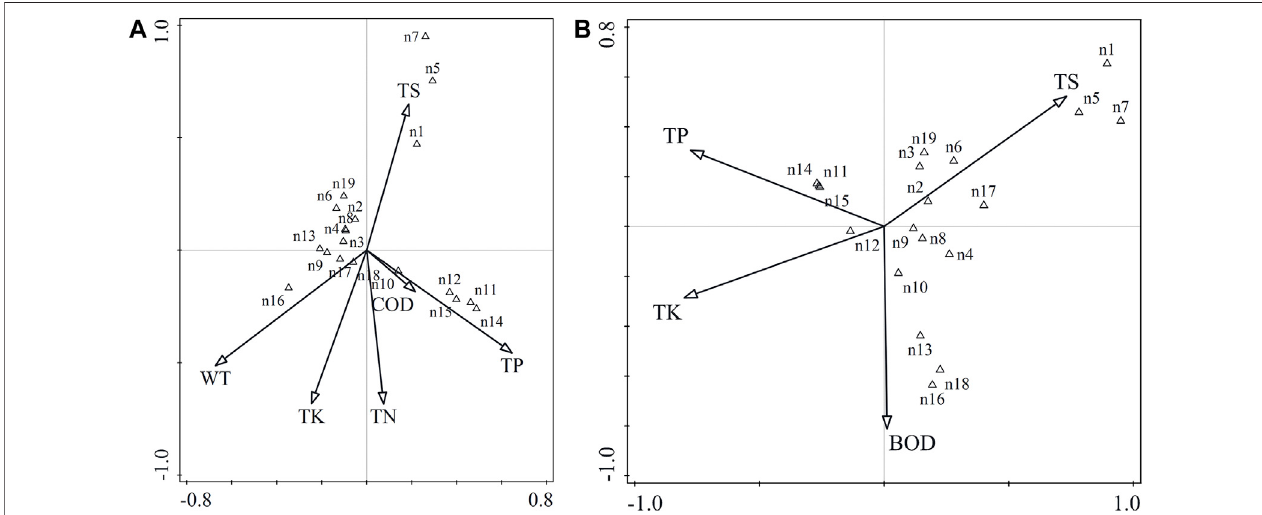
FIGURE 5 | Correlation plots of the redundancy analysis (CCA) on the relationship between the environment variables and dominant species of phytoplankton. PanelsshowCCAbetweentheenvironmentvariablesandabundance (A) ,biomass (B) .Inthis fi gure,theblackarrowrepresentstheenvironmentvariable,andthearrow points tothedirectioninwhichthevalueoftheenvironmentvariableincreasesmostsharply.Theanglebetweenthearrowsindicatesthecorrelationbetweenthevarious environmentvariables. Theblacktrianglerepresentsspecies,and thedistancebetweensymbolsissimilartotherelative abundancedistributionofthesespeciesin the sample measured by chi-square distance. Adjacent points correspond to species that often occur at the same time. The species symbol can be projected vertically onto the line above the arrow of a speci fi c environmental variable. These forecasts are made according to the predicted growth order of the best value of the prediction